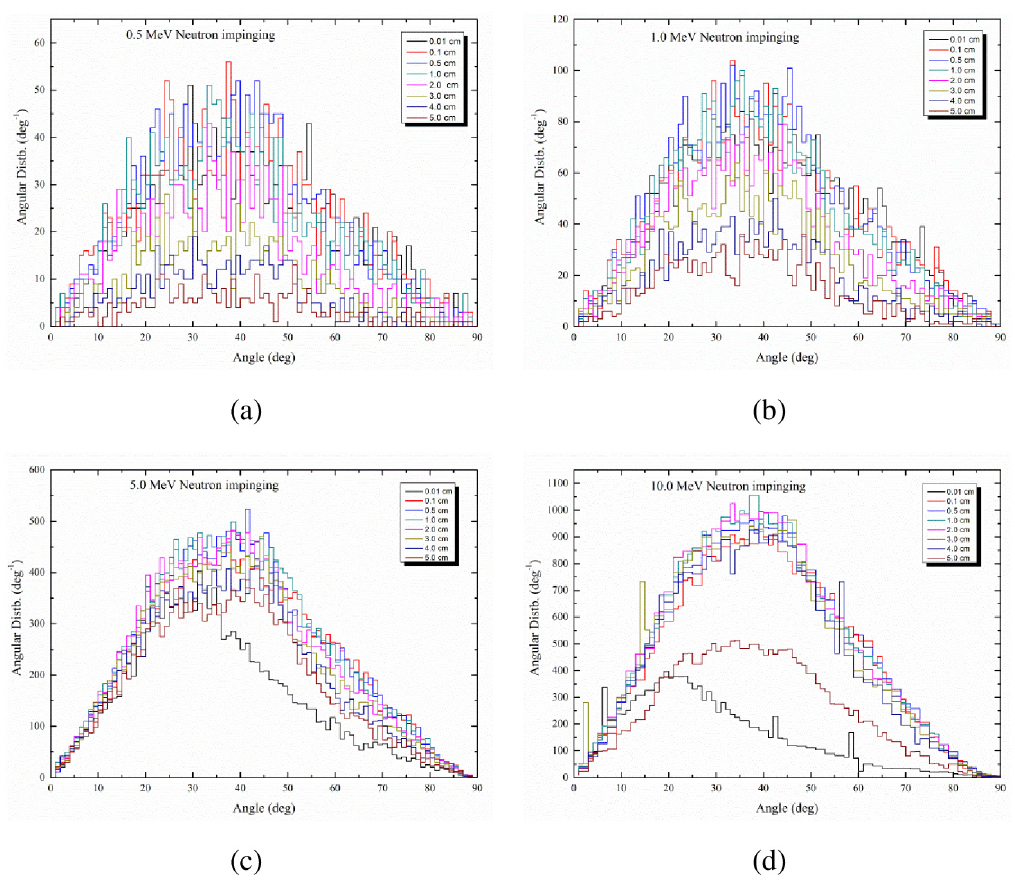
Fig 9. Distribution of protons as a function of the angle with the thickness of the PE layer as a parameter (in cm). (a) For incident neutron energy of 0.5 MeV; (b) for incident neutron energy of 1 MeV; (c) for incident neutron energy of 5 MeV; (d) for incident neutron energy of 10